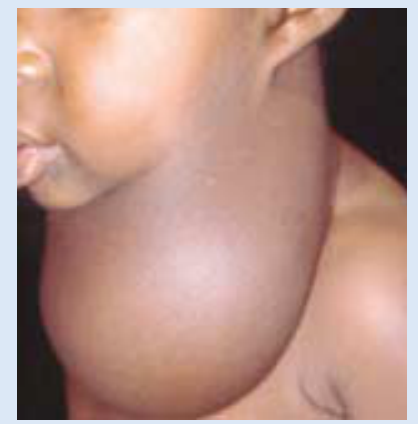
Fig. 5a. Macrocystic lymphatic malformation of the neck. Previously termed cystic hygroma.